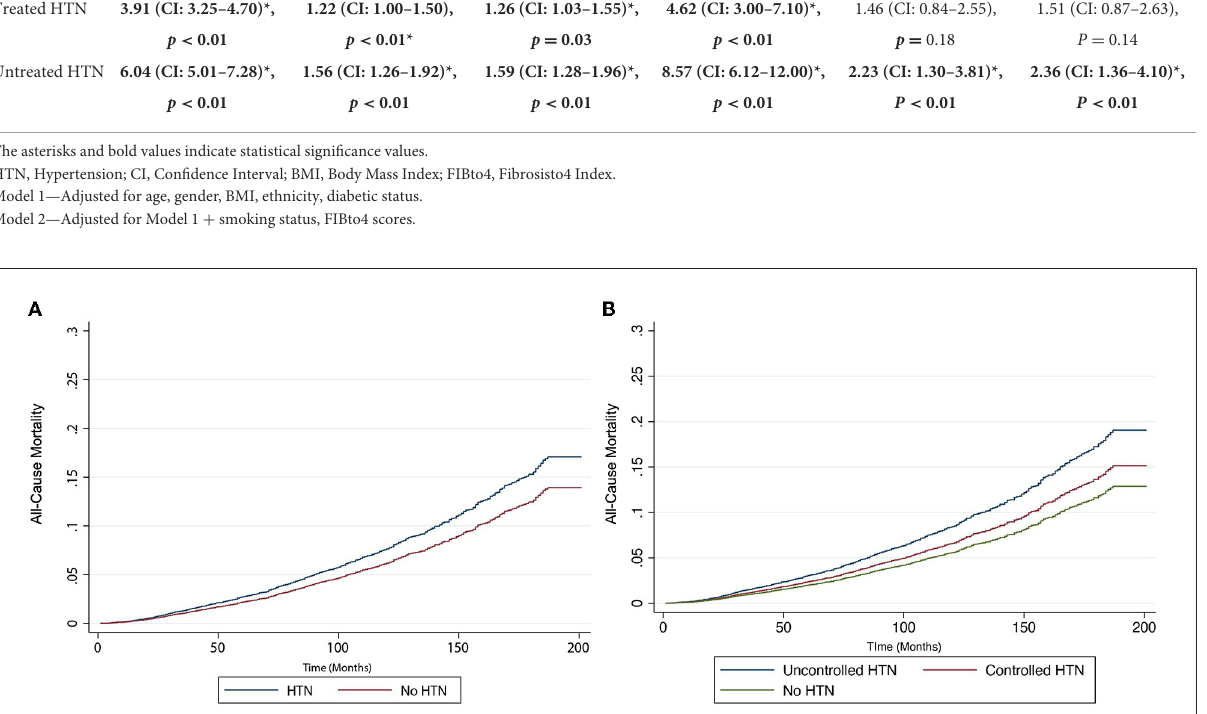
FIGURE1 Risk of all-cause mortality in individuals with non-alcoholic fatty liver disease (NAFLD). (A) with and without hypertension and (B) with controlled hypertension, uncontrolled hypertension, and no